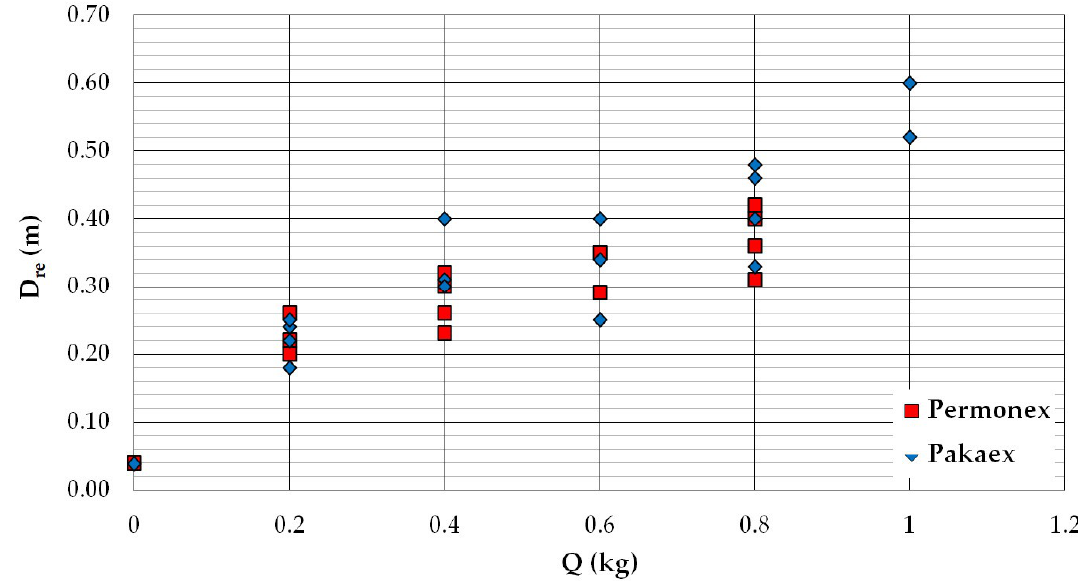
Figure 10. The dependence of the resulting volume of expansion V rc (m 3 ) on the mass of explosive charge Q (kg), for Permonex V19 and Pakaex.